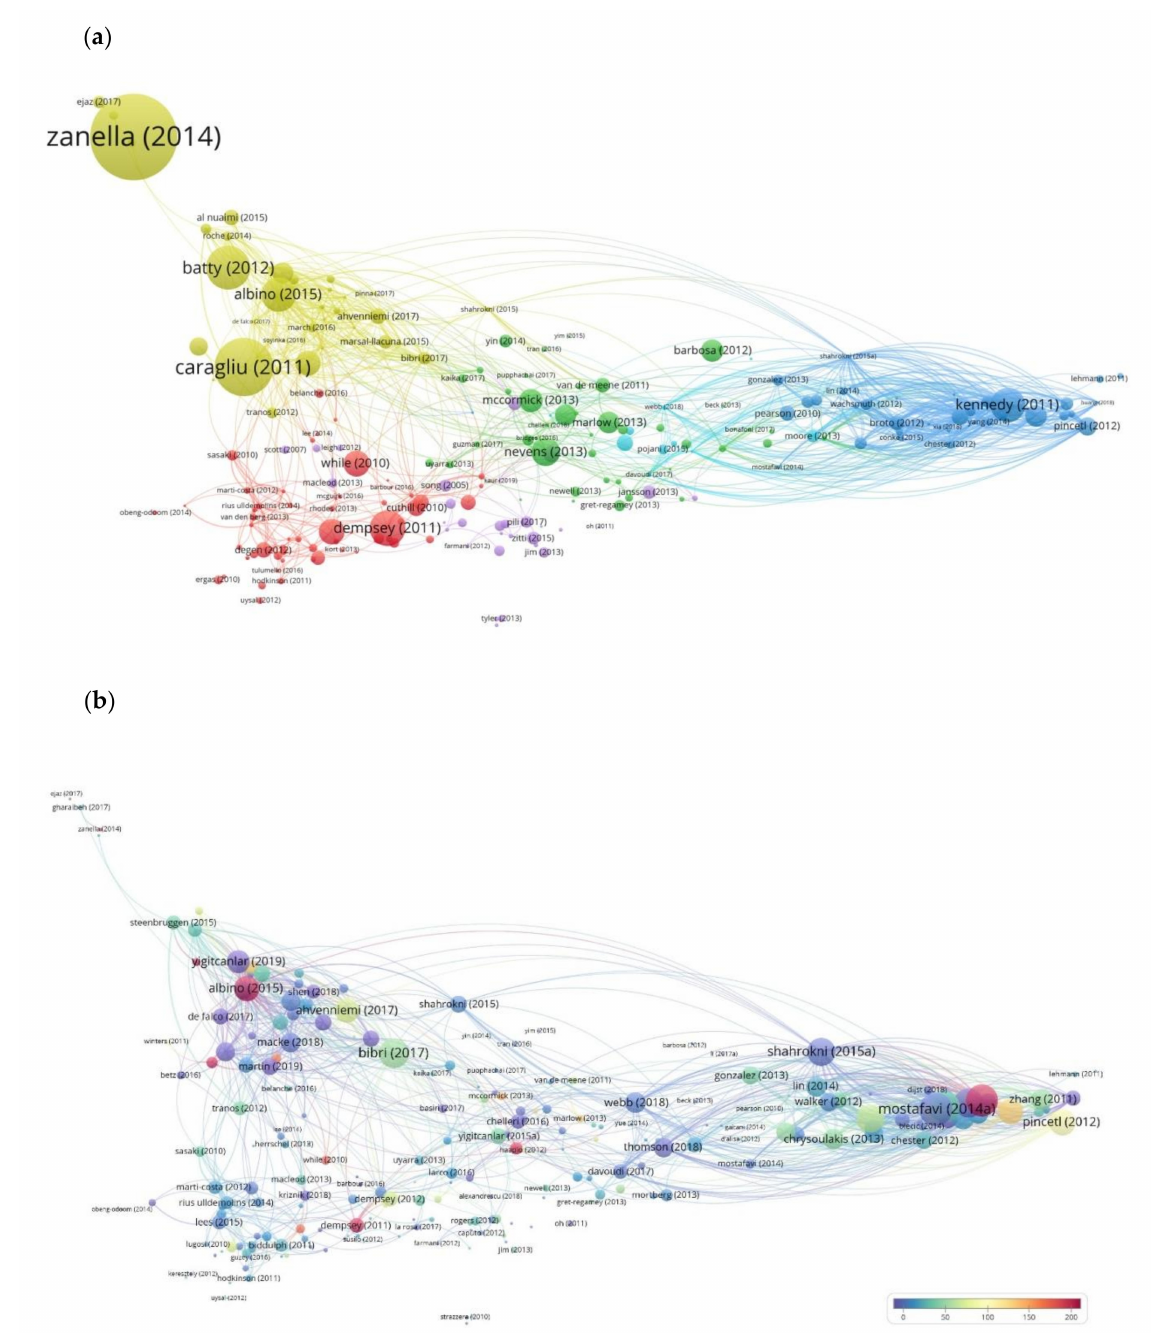
Figure 5. ( a ). Map of bibliographic coupling analysis based on documents with the weights of the links on the number of citations. ( b ). Map of bibliographic coupling analysis based on documents with the weights of the links on the total links strength and indicating the number of